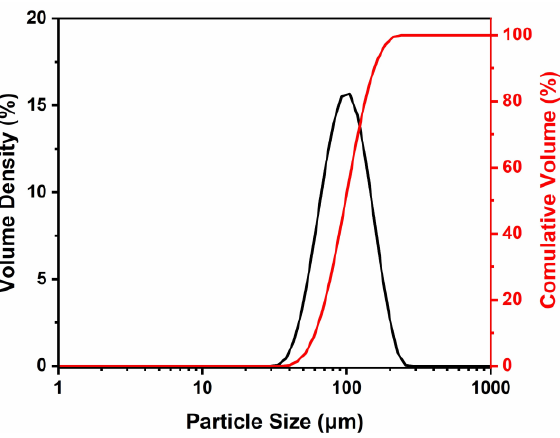
Figure 1. Particle size distribution of the powder used in this study. Table 1. Chemical composition (at.%) of the pre-alloyed powder determined by OES-ICP analysis. Element Ti Al Cr Nb Powder Bal. 48.7 1.9